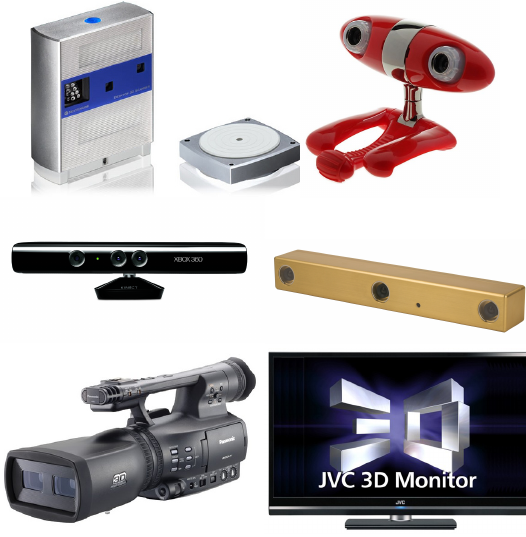
Fig. 5. Lab equipments used for 3D